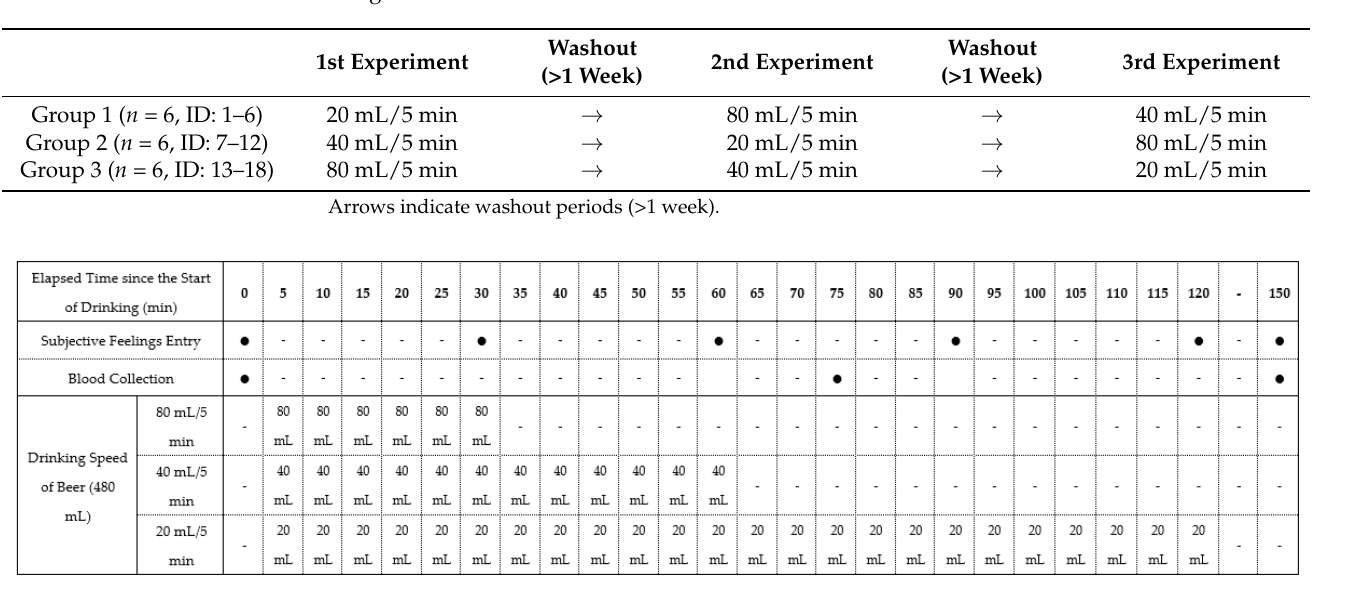
Table 1. Study schedule showing the nonblind, single-center, randomized crossover pilot study design.